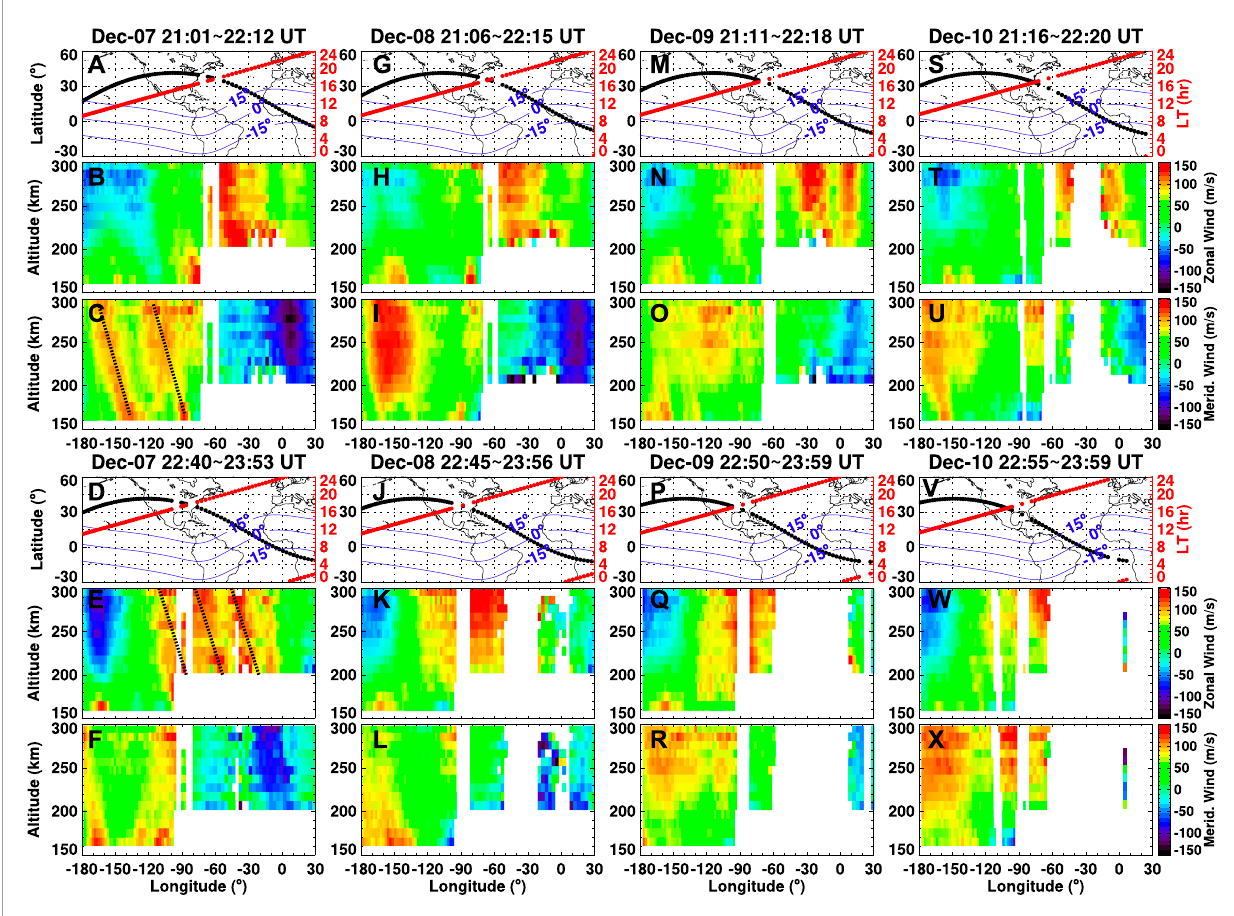
FIGURE 7 ICON MIGHTI observation tracks and corresponding local time, zonal wind (positive eastward), and meridional wind (positive northward) profiles for two consecutive orbits over American sector between 21 and 24 UT on December 07 (A–F) , December 08 (G–L) , December 09 (M–R) , and December 10 (S–X) , 2019, respectively. The geomagnetic dip equator and ± 15 ° latitudes are shown by blue lines. The parallel dotted lines in (C,E) mark large neutral wind oscillations with a downward phase propagation